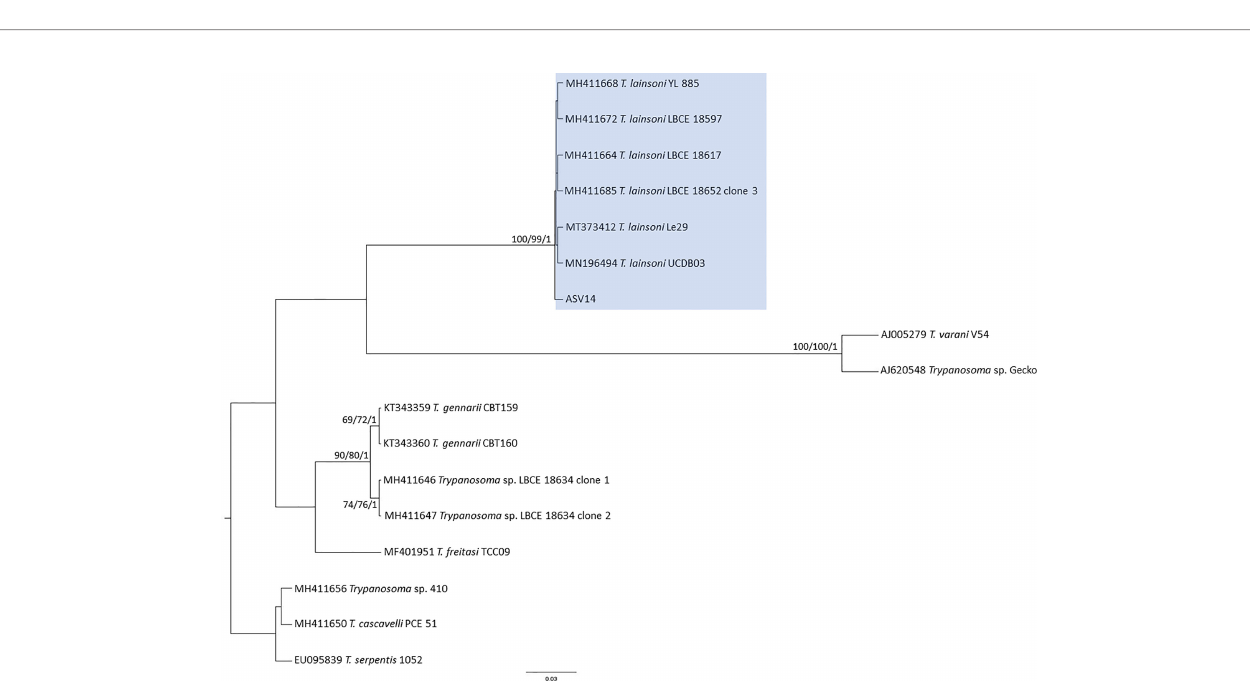
FIGURE 4 | Trypanosoma lainsoni phylogenetic tree based on 492bp 18S rDNA fragment length from D. albiventris and R. rattus hemoculture samples. The tree was inferred with Bayesian using transition model with plus gamma distribution among sites (TIM3+G) model for ML and BI. The number at nodes corresponds to ML (ultrabootstrap and SH-aLRT) and BI (posterior probability). The scale bar shows the number of nucleotide substitutions per